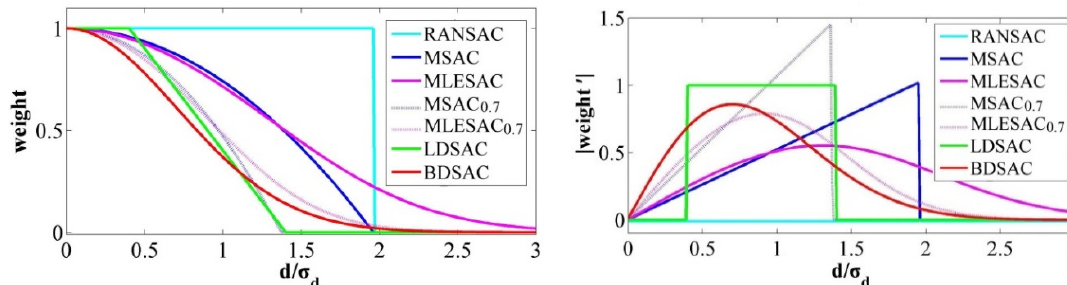
Figure 3. Weight functions of various RANSAC methods: ( Left ) Plots of the weight functions; ( Right ) Plots of the absolute value of gradient.